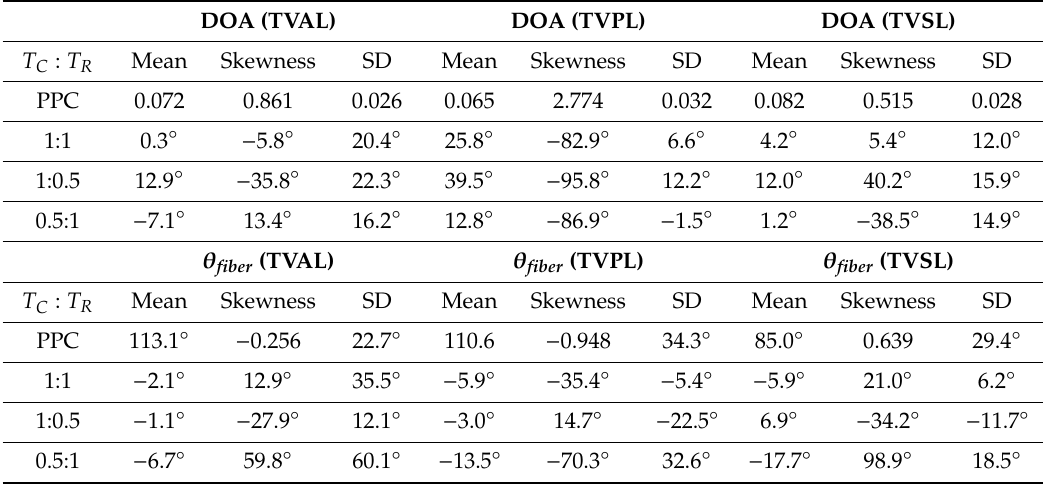
Table A2. The percent changes in mean, skewness, and standard deviation (SD) for the predicted θ fiber and the DOA of the entire tissue’s ROI, for the TVAL, TVPL, and TVSL specimens of heart